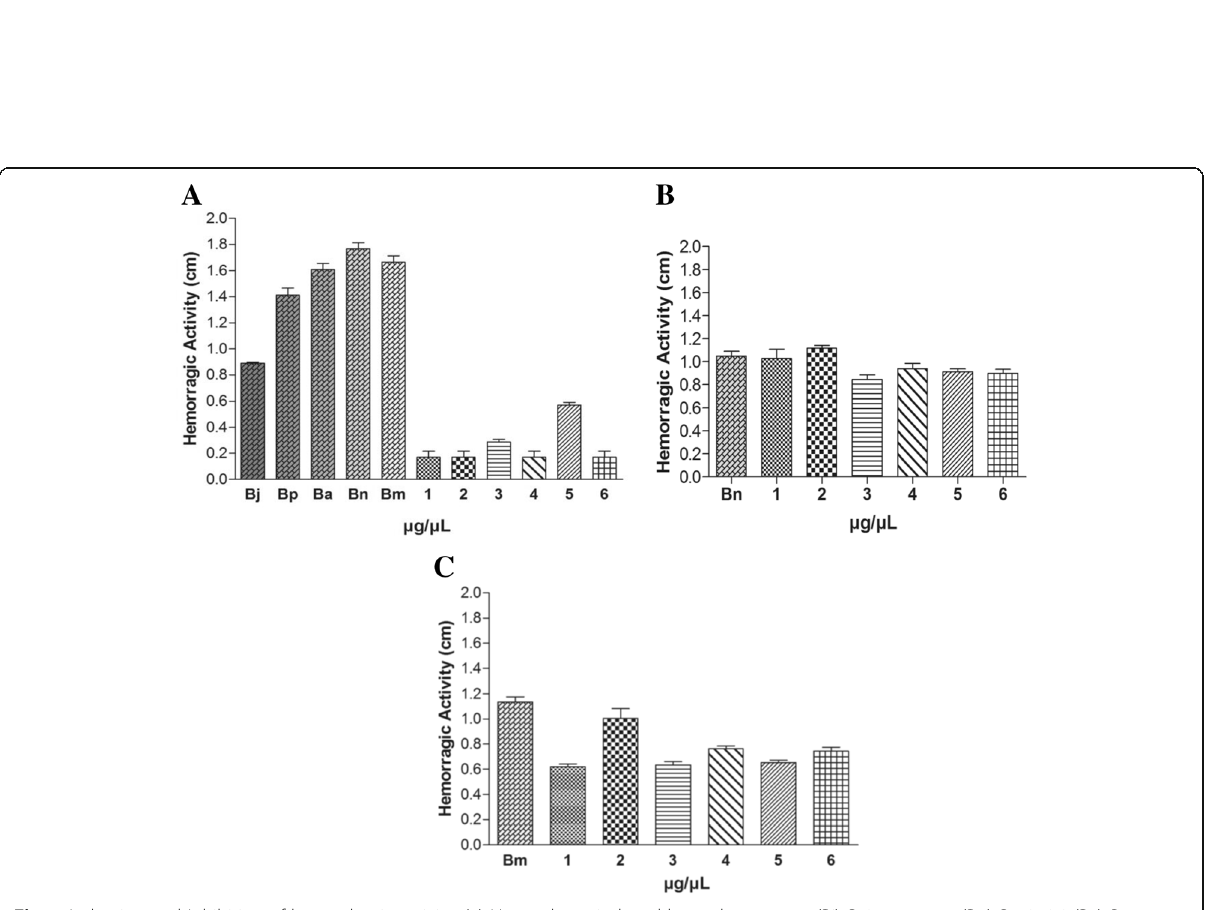
Fig. 4 Induction and Inhibition of hemorrhagic activity. ( a ) Hemorrhage induced by snake venoms: (Bj) B. jararacussu , (Bp) B. pirajai , (Ba) B. alternatus , (Bn) B. neuwiedi , (Bm) B. moojeni - all venoms at 30 μ g and, cnidarian extracts: (1) C. gigantea (body-wall), (2) C. gigantea (total), (3) M. alcicornis, (4) S. helianthus (5) P. homomalla , (6) B. annulata - all extracts at 150 μ g. ( b ) Inhibition of hemorrhagic activity induced by B. neuwiedi (Bn) at 20 μ g and; ( c ) Inhibition of haemorrhagic activity induced by B. moojeni (Bm) at 10 μ g. Results are reported as mean % ± S. D (n = 3)